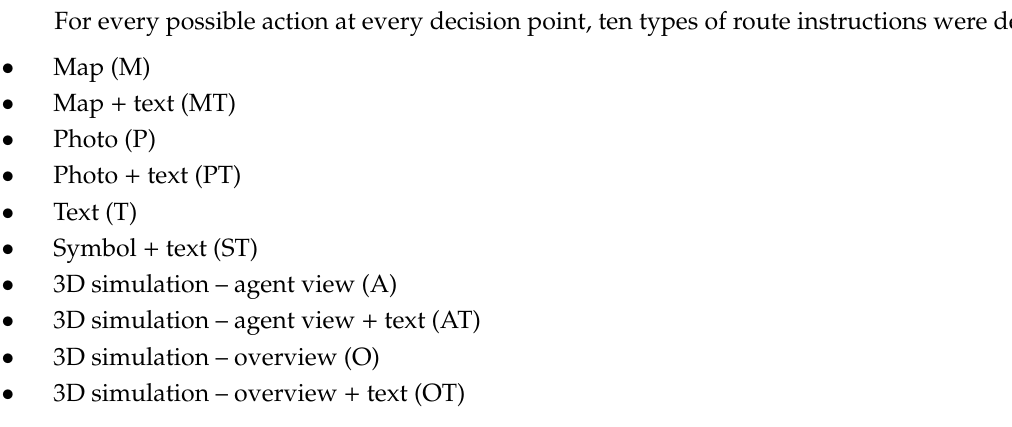
Figure 2. Example route.